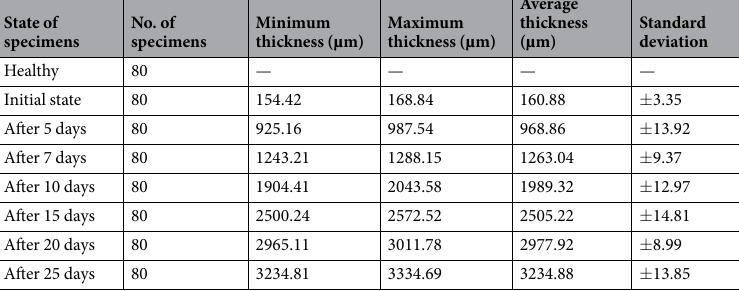
Table 1. Statistical data of thickness expansion along the lateral direction.